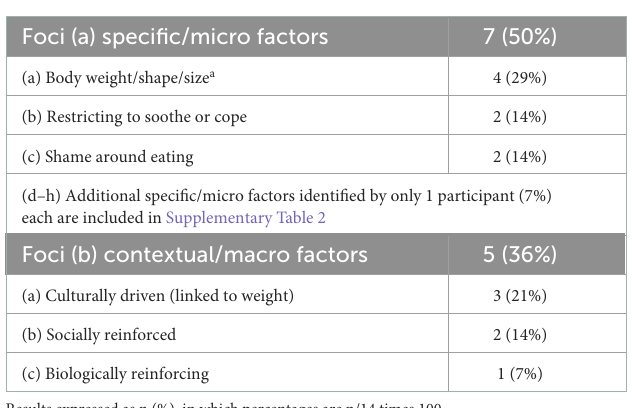
Foci b: negative affective states (71%) Ten (10/14, 71%) provided descriptions of negative